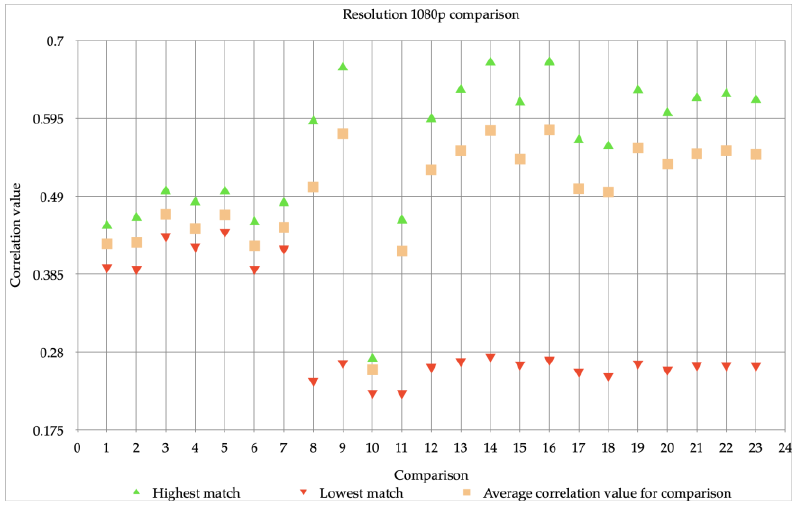
Figure 2. 23 comparisons, done with images made with an iPhone 6, all with a resolution of